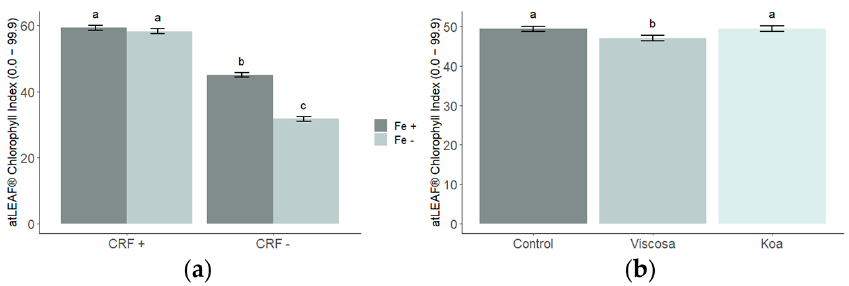
Figure 3. Mean ( ± SE) chlorophyll index values. ( a ) The interaction between CRF and chelated iron significantly affected the chlorophyll index, causing chelated iron to have an effect only when applied without CRF. ( b ) Seedlings paired with D. viscosa had a lower chlorophyll index value than A. koa -paired and control seedlings. Different letters indicate significant differences among treatments ( α = 0.05). Fe+ = chelated Fe applied; Fe − = control; CRF+ = CRF applied; CRF − = control.